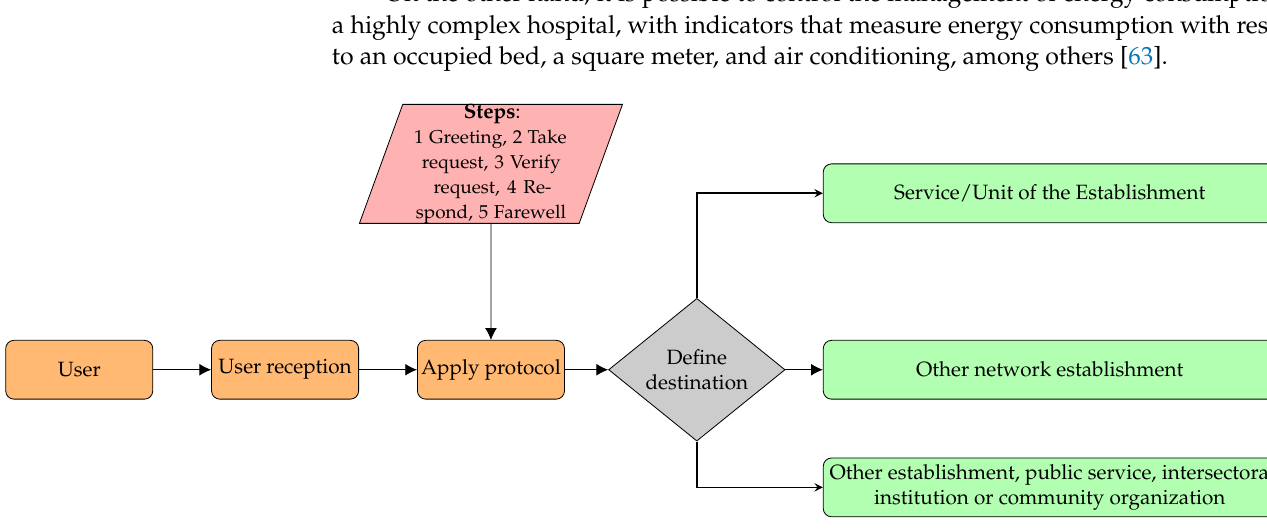
Figure 1. Protocols used in the process of